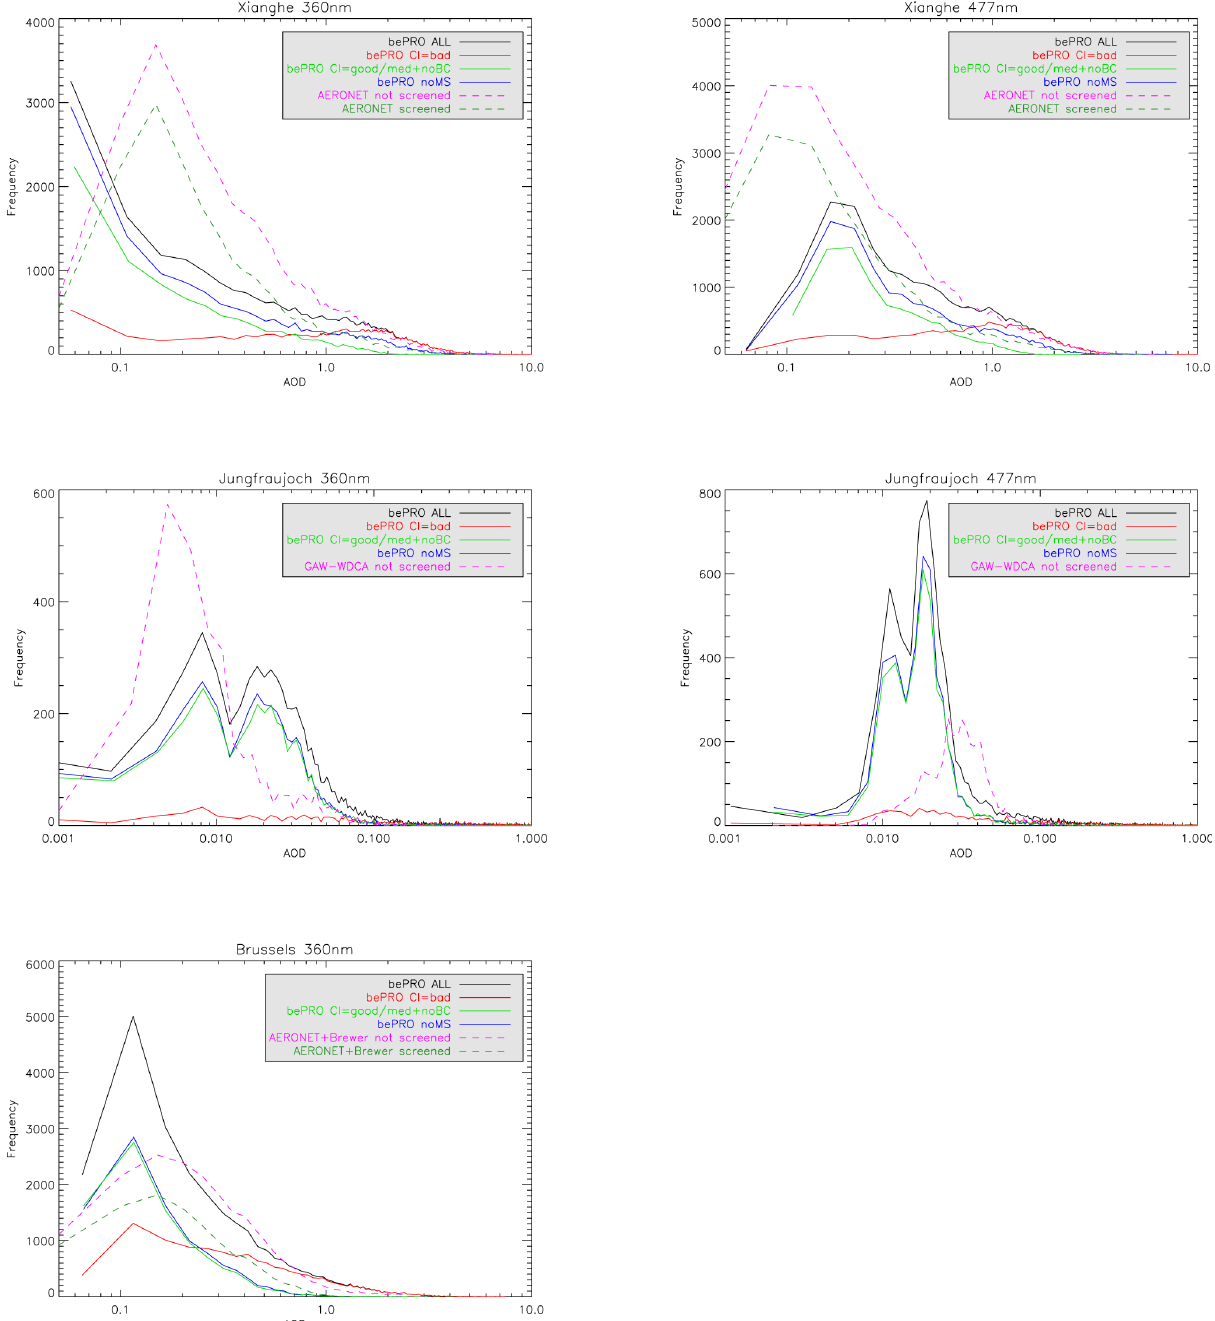
Figure 13. Histograms of our bePRO AOD retrievals and co-located AOD measurements for the three data sets. The bePRO retrievals are plotted in full lines, with black, red, green and blue respectively the unscreened data, data with “bad” CI flag, “good” CI flag and no broken- cloud flag, and no multiple-scattering flag. The co-located measurements are plotted in dashed lines, with magenta being the unscreened data and dark green the cloud-screened